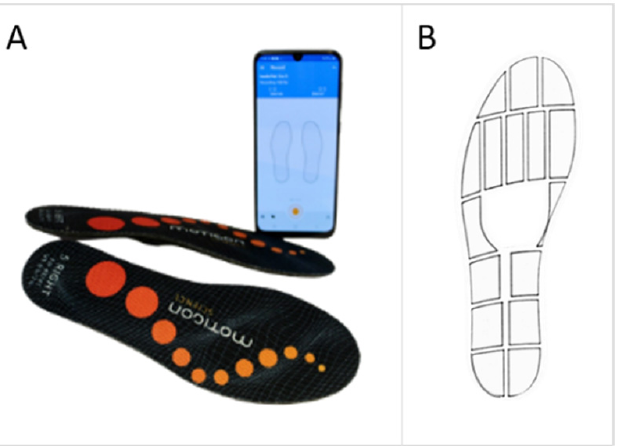
Figure 1. ( A ) The Insole3 (Moticon ReGo AG, Munich, Germany) and the OpenGo smartphone application. ( B ) Layout of the 16 pressure sensors and coordinate system. Figure 1B used and modified with permission from Moticon ReGo AG.